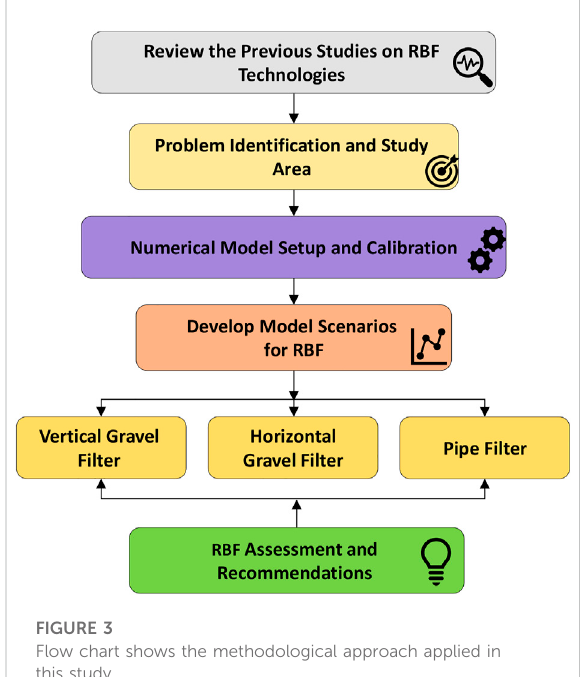
FIGURE 3 Flow chart shows the methodological approach applied in this study.